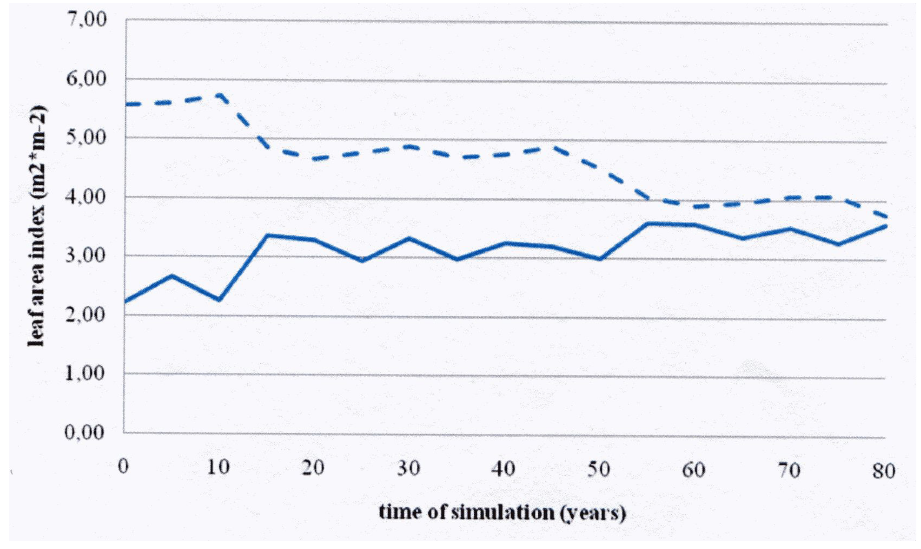
Figure 4. Time development of the leaf area index in study site Jeleni Bucina (solid line) and Bucina pod Frantiskovou Myslivnou (dashed line) for prediction period of 80